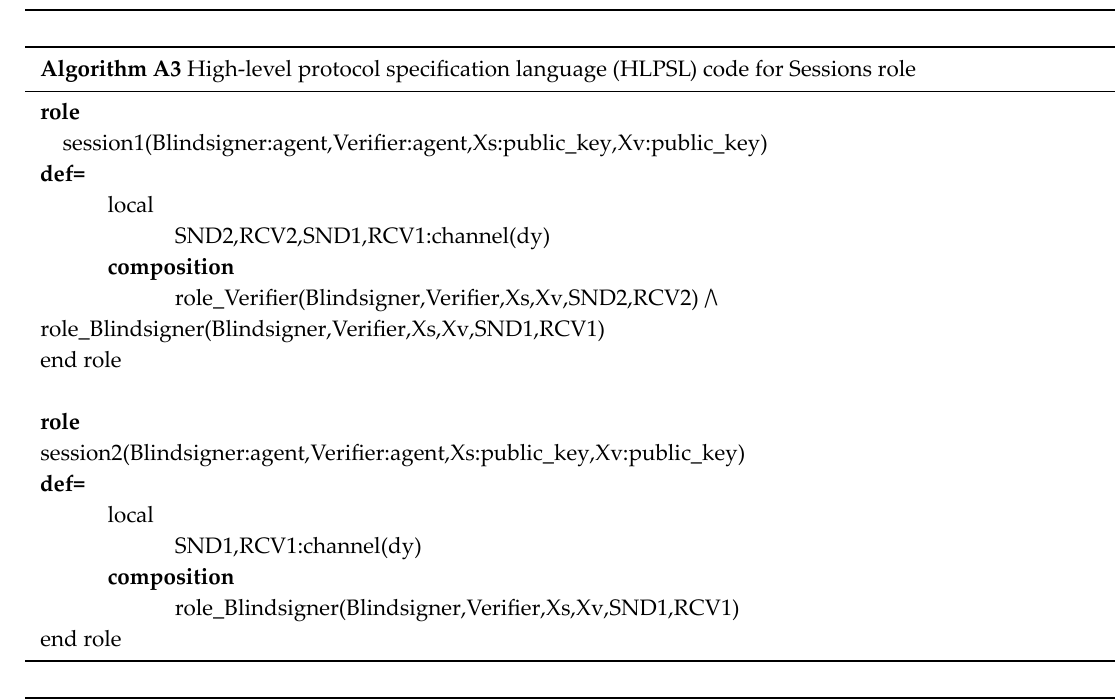
Algorithm A4 High-level protocol specification language (HLPSL) code for Environment role